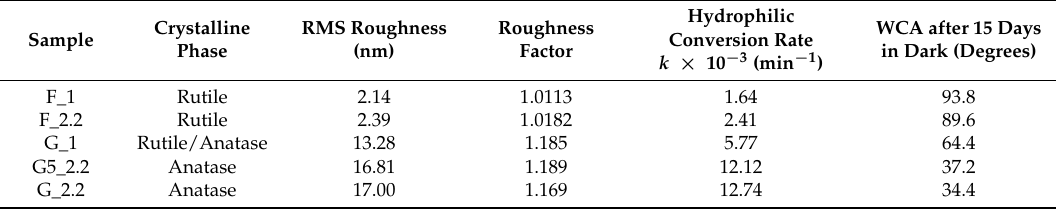
Figure 7. Correlation of the TiO 2 films wetting properties with the average RMS roughness and the corresponding roughness factor. R and A symbols indicate the crystalline phase. Black symbols: hydrophilic conversion rate constant (min − 1 ). Blue symbols: measured contact angle after 15 days in dark ambient conditions. Orange symbols: surface roughness factor defined as real surface area/apparent area. Table 2. The TiO 2 thin films surface properties (RMS roughness and roughness factor), hydrophilic conversion rate, water contact angle (WCA) and their corresponding crystalline